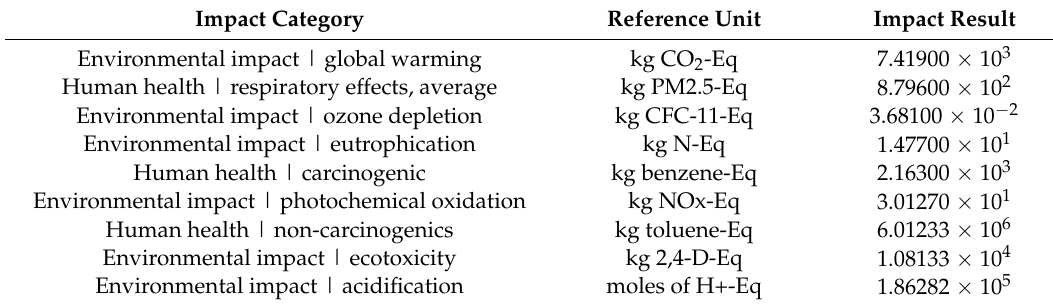
Table 5. LCIA results of unmodified (conventional) asphalt materials per